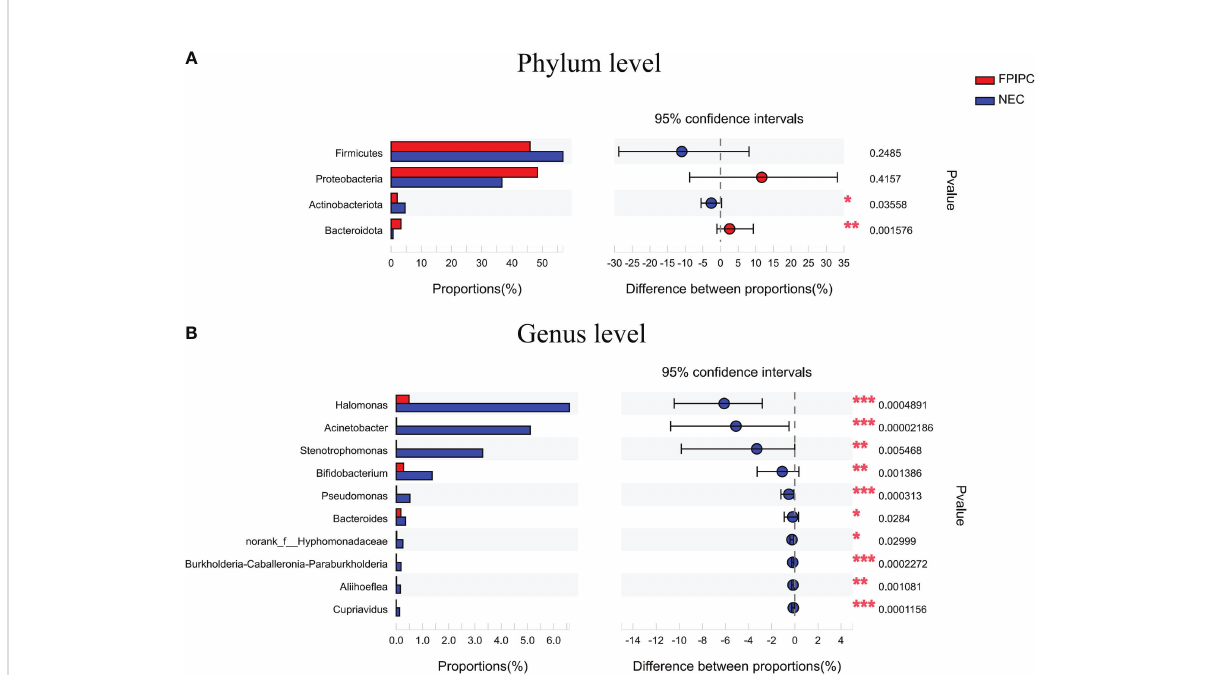
FIGURE 4 Relative abundances at the phylum level (A) and the genus level (B) in the necrotizing enterocolitis (NEC) and food protein-induced allergic protocolitis (FPIAP) groups. There were signi fi cant differences between the NEC and FPIAP groups in gut microbiota at the phylum and genus levels. * P <0.05, ** P <0.01, ***, and P <0.001. Data was presented as means±SEM, N =22 for NEC and N =21 for